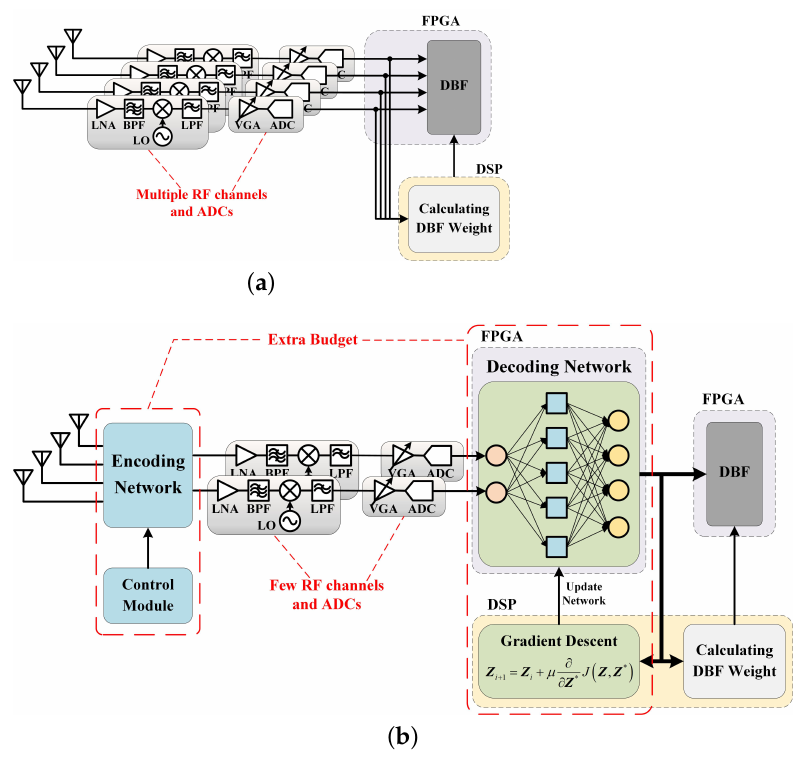
Figure 12. The implementation architectures for the full-channel DRA and the ML-CDRA. ( a ) A typical architecture for full-channel DRA. ( b ) A real-time processing architecture for ML-CDRA with the decoding network implemented by